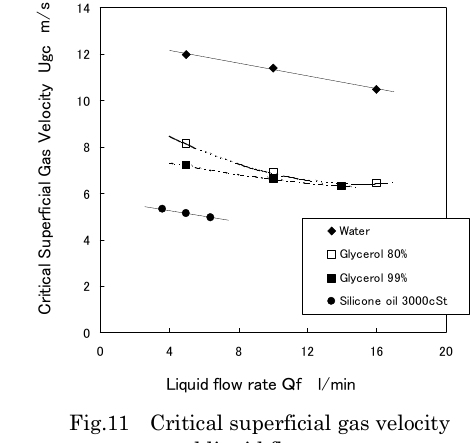
Fig.11 Critical superficial gas velocity and liquid flow rate